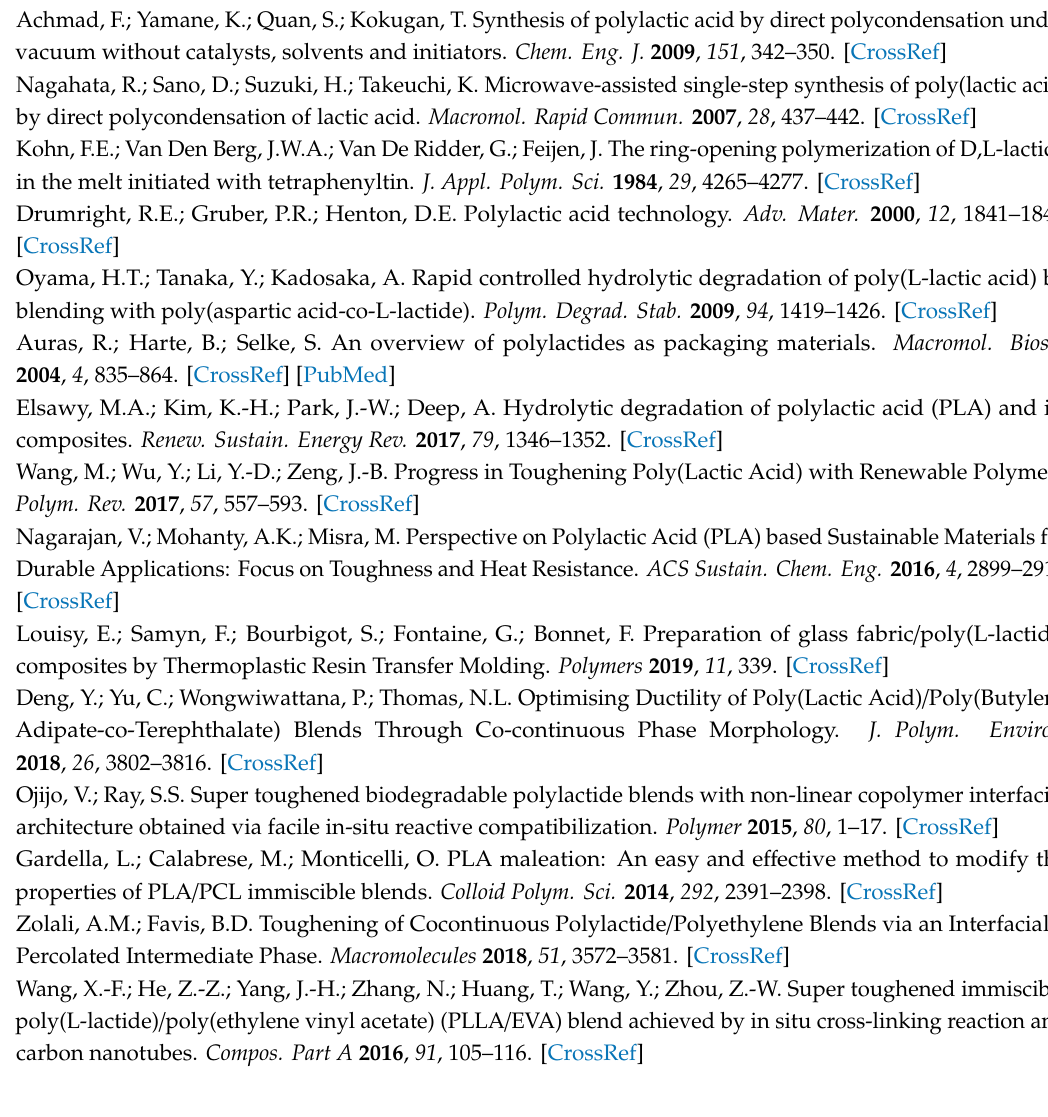
Figure S1: Tensile stress–strain curves of PLLA and PLLA / EPDM / OMMT (90 / 10 / x ) samples prepared by (a) compression-molding and (b) calendering. Figure S2: SEM images of cyclohexane-etch cryogenically fracture surfaces and EPDM particle diameter distribution of PLLA / EPDM / OMMT (90 / 10 / x ) samples prepared by compression-molding (A2-90 / 10, A3-90 / 10 / 1, A4-90 / 10 / 2, A5-90 / 10 / 4). Figure S3: SEM images